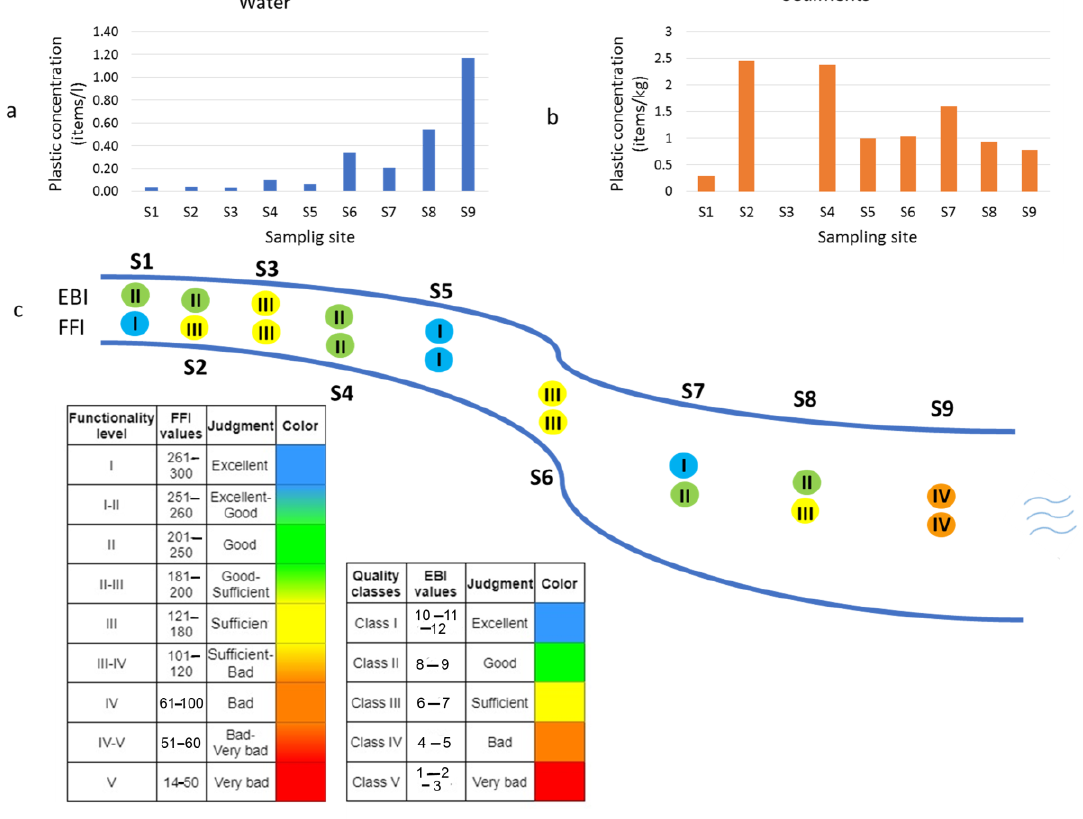
Figure 8. ( a ) Plastic concentration in water samples by station, ( b ) plastic concentration in sediment samples by station, ( c ) Extended Biotic Index (EBI) and Fluvial Functionality Index (FFI) results for each station by class and color (see the legends for details on the corresponding values and judgment).